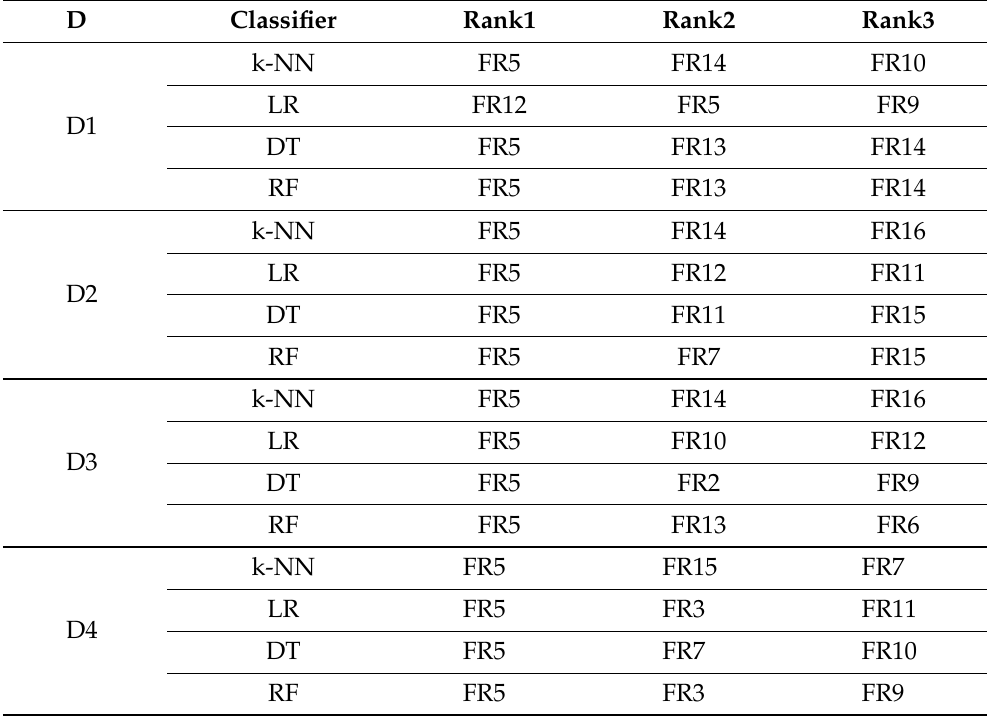
Table 9. Ranking and Selection of Top Three FR.